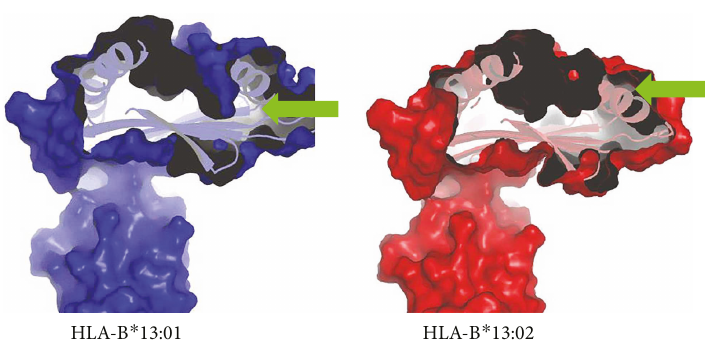
Figure 3: Anextra-deep subpocket around theF-pocket ofthe antigen-binding site ofHLA-B ∗ 13:01, whichwasnot observedin HLA-B ∗ 13:02. HLA-B ∗ 13:01 (blue) had an extra-deep subpocket (green arrows) absent from HLA-B ∗ 13:02 (red).